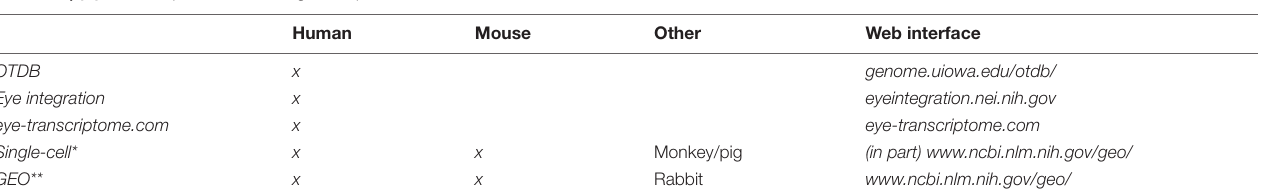
TABLE 1 | (B) Source species of ocular gene expression datasets. Human Mouse